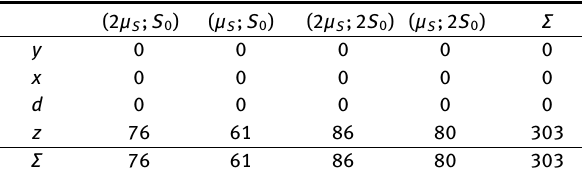
Table 2. Simulations with zero magnetic moment and S = 2 S 0 .